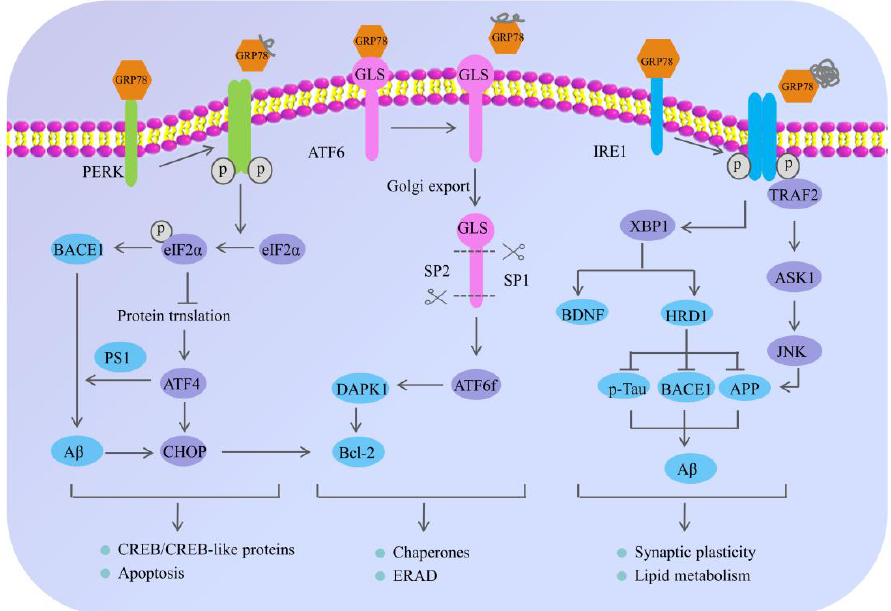
Figure 2. The mechanism of endoplasmic reticulum stress and its potential role in Alzheimer’s disease. Under normal physiological conditions, the ER sensors including PERK, ATF6 and IRE1 are inactivated through the interaction with 78 kDa glucose-regulated protein (GRP78); however, the misfolded proteins preferentially bind to GRP78, causing the dissociation of GRP78 from PERK, IRE1 and ATF6, eventually resulting in the phosphorylation of PERK and IRE-1, and the transloca- tion of ATF6 to the Golgi. The activation of these signaling pathways regulates the expression of reticulum homeostasis. In neurons, under chronic ERS, the sustained activation of PERK leads to eIF2 α phosphorylation, which not only influences the neuronal plasticity through protein synthesis